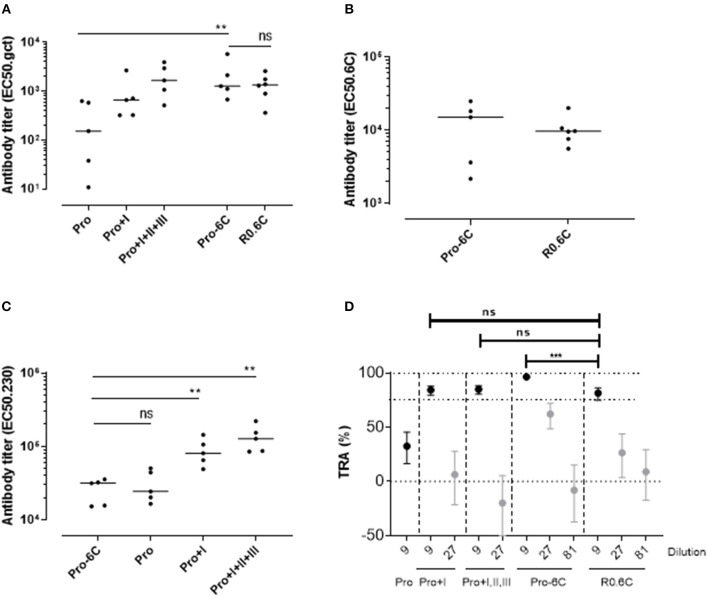
Immunogenicity of Pro-6C and individual fragments. Groups of mice (n = 5) were immunized with immune purified Pro-6C in a comparative study with individual Pro, Pro+I, Pro+I,II,III and R0.6C constructs. Day 56 serum was tested for antibody reactivity on ELISA plates coated with (A) gametocyte extract, (B)
Pfs48/45-6C or (C)
Pfs230 Pro+I,II,III. Antibody titers (dots represent individual mice) are expressed as EC50 values. Horizontal lines represent median values. The asterisks represent statistical significance determined by Mann-Whitney test (**p < 0.01, ns not significant). (D) Functional activity of serial dilutions of pooled sera in the SMFA. Transmission reducing activity (TRA) is the reduction of oocyst numbers compared to a serum control. All samples were tested in the presence of active complement. Data points are best estimates of two independent SMFA experiments and error bars represent 95% confidence intervals. Comparison between test samples was done using General Linear Mixed Regression analysis (***p < 0.005, ns, not significant).